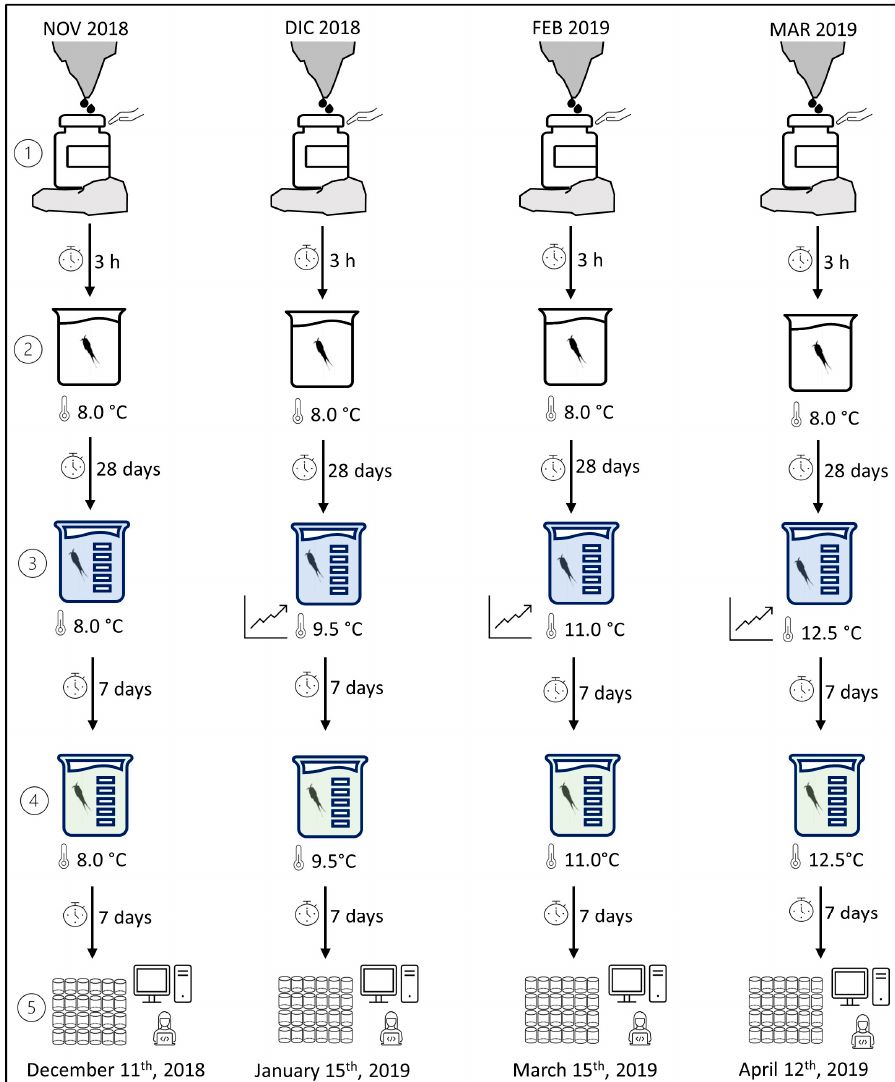
Figure 3. Phases of the experiment performed with adult females of Moraria sp. The specimens were: (1) collected from the dripping waters of the Corchia Cave (Apuan Alps; Italy) and transported to the laboratory within 3 h of collection; (2) acclimated at the laboratory conditions at the temperature of the collection site for 28 days; (3) acclimated to the new medium (50 mL of drip water and 50 mL of remineralized MILLI-Q water) and, eventually, temperature for 7 days; (4) acclimated to the new medium (100 mL of remineralized MILLI-Q water) for 7 more days and (5) loaded in the 80 µ L glass wells for measurements of the oxygen consumption